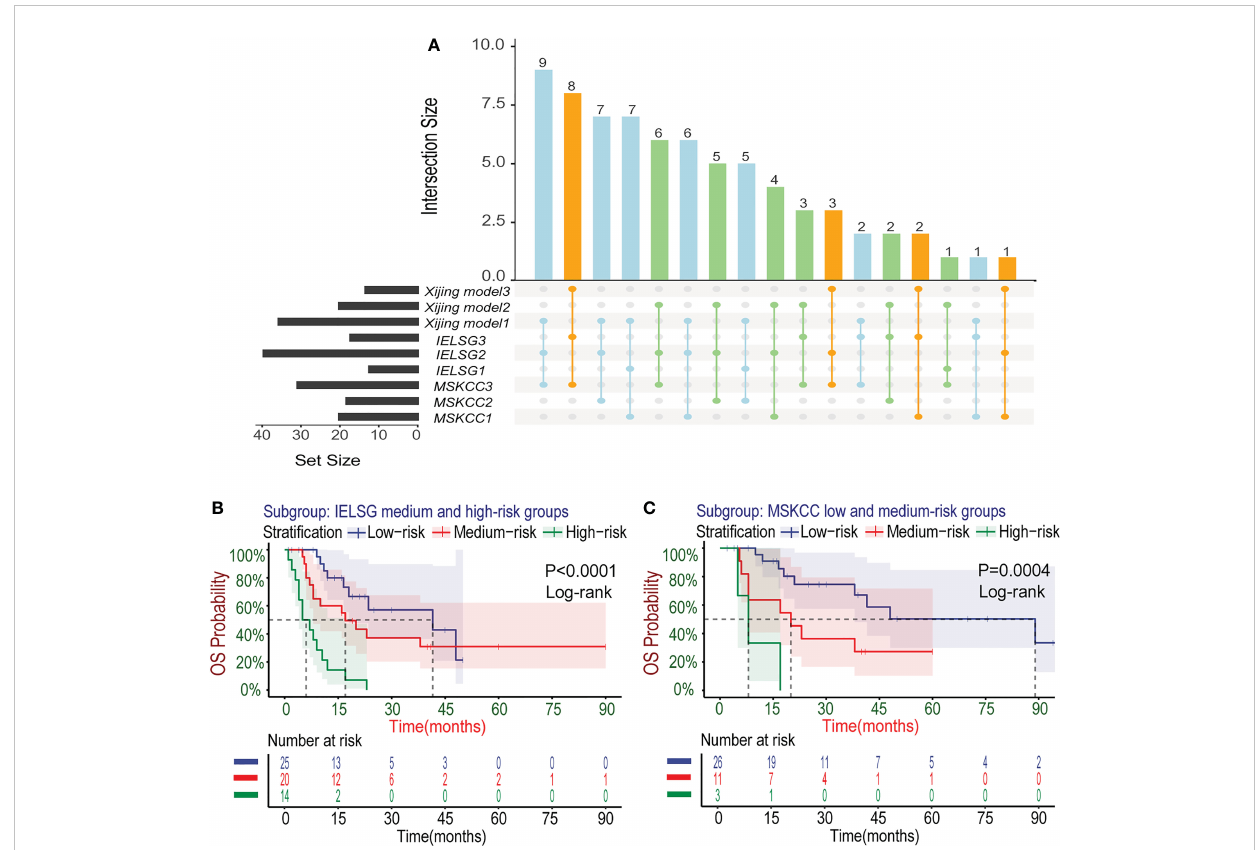
FIGURE 5 Subgroup analysis about the three risk strati fi cations in the development cohort. (A) The distribution and co-occurrence of the patients respectively classi fi ed by the Xijing Model, IELSG and MSKCC scores in the development cohort were shown. Dots and their connected lines indicate that the patients coexisted in different strati fi cations and the vertical bar graphs re fl ect the number of these patients. Also, the blue, orange and green dots respectively represent the co-occurrence of the patients who were classi fi ed into low, median and high-risk groups by the Xijing Model and other two scores. (B) Subgroup analysis with the survival curves for OS in the medium and high-risk groups of IELSG score strati fi ed by the Xiijing model. (C) Subgroup analysis with the survival curves for OS in the low and medium-risk groups of MSKCC score strati fi ed by the Xijing